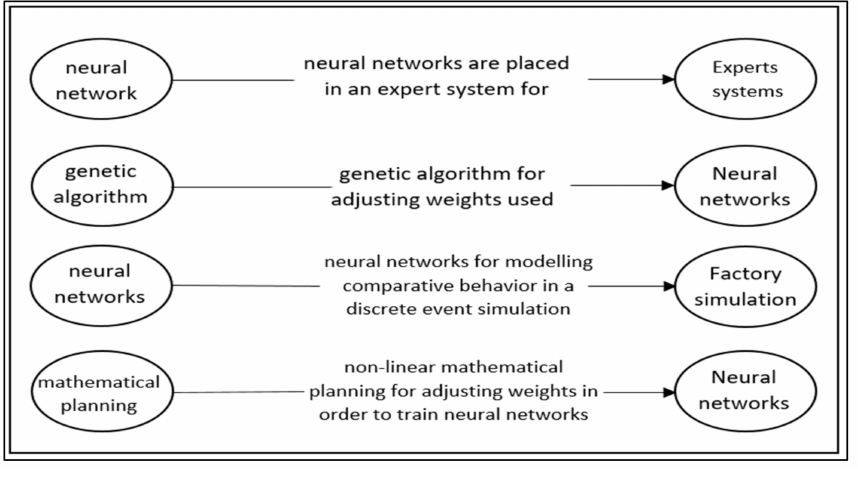
Figure 9. Combined intelligent